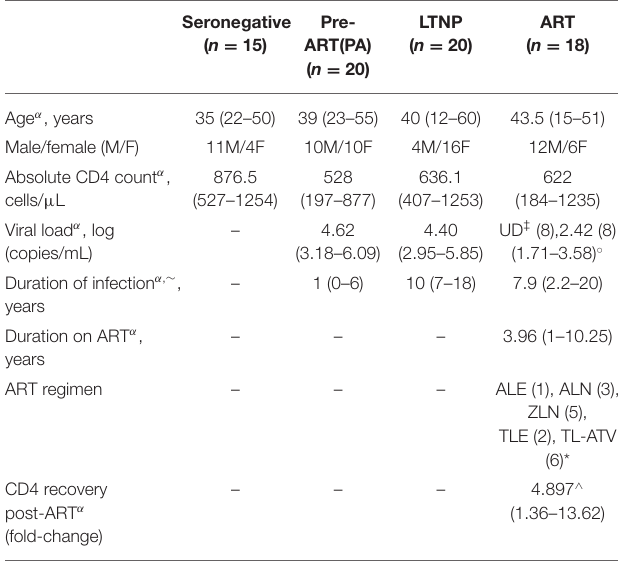
TABLE 1 | Clinical characteristics of